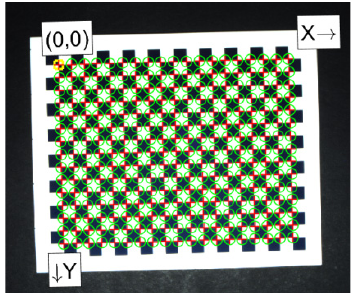
Figure 12. Calibration plate image.